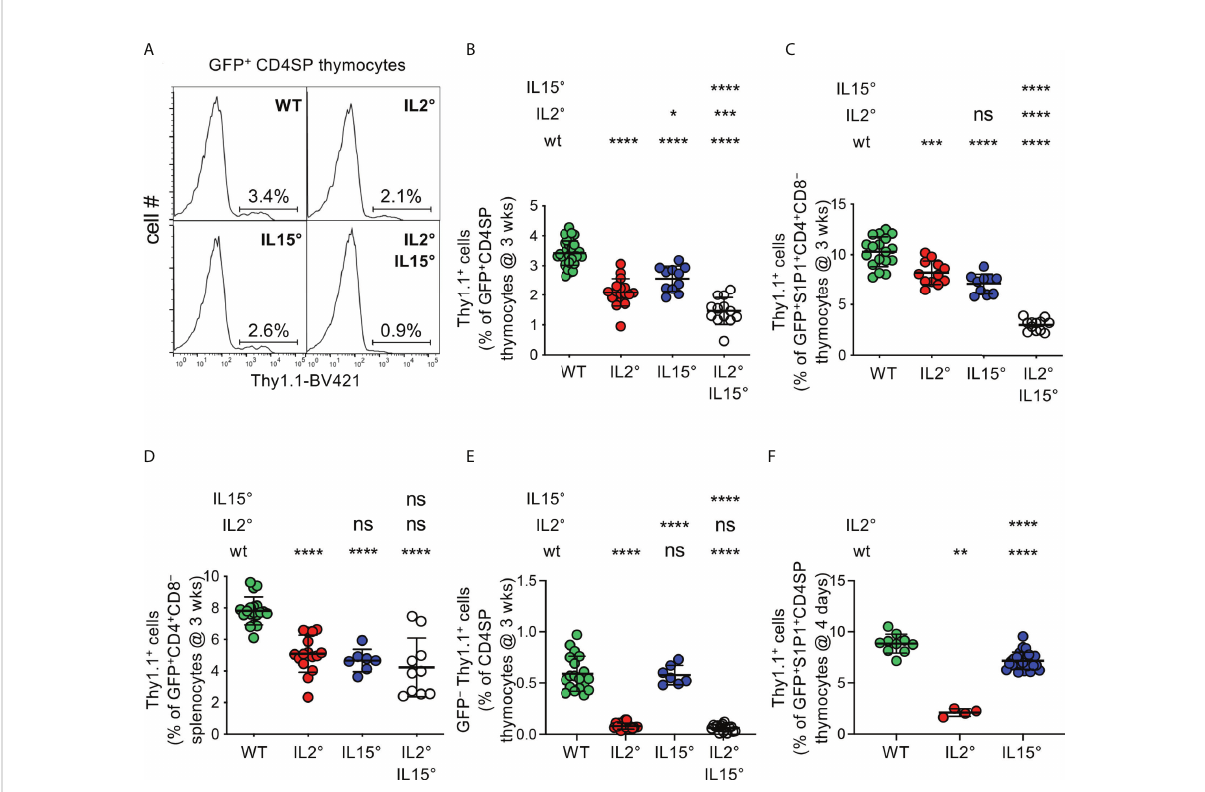
FIGURE 1 IL-2 and IL-15 quantitatively regulate intrathymic Treg-development. Thymocytes from (A – E) three-week-old or (F) four-day-old Rag-Gfp Foxp3-Thy1 a mutant, Il2° and/or Il15° mice, and Il2 wt/wt and Il15 wt/wt littermates (for absolute numbers see Figure S1A), were stained with fl uorescent antibodies against indicated markers and analysed by fl ow cytometry. (A) Representative histograms of Thy1.1 expression (indicating Foxp3-expression) on GFP + ( i.e. newly developed) CD4 + CD8 − TCR high (CD4SP) thymocytes (gated as in Figure S1B). Indicated gates were used for the quanti fi cation of Thy1.1 + Treg. (B) Percentages of Treg among GFP + CD4SP thymocytes from indicated mice (n=31, 17, 11, and 13 wt, Il2°, Il15° , and Il2°Il15° mice, respectively). (C) Percentages of Treg among GFP + S1P1 + CD4 + CD8 − thymocytes (n=18, 12, 10, and 12 mice). For S1P1 gates see Figure S1E. (D) Percentages of Treg among RTE in the spleen (n=19, 16, 7, 10 mice). For RTE gates see Figure S1F. (E) Percentages of GFP − (recirculating) Treg among CD4SP thymocytes (n=19, 17, 7, and 15 mice). For recirculating Treg-gates see Figure S1G. (F) Percentages of Treg among GFP + S1P1 + CD4SP thymocytes from four-day-old mice (n=10, 4, and 25 mice) For absolute numbers see Figure S1H. Dots indicate individual mice. ns, not signi fi cant; * p < 0.05; ** p < 0.01; *** p < 0.001; **** p < 0.0001 (Mann-Whitney test). Bars indicate mean values ±